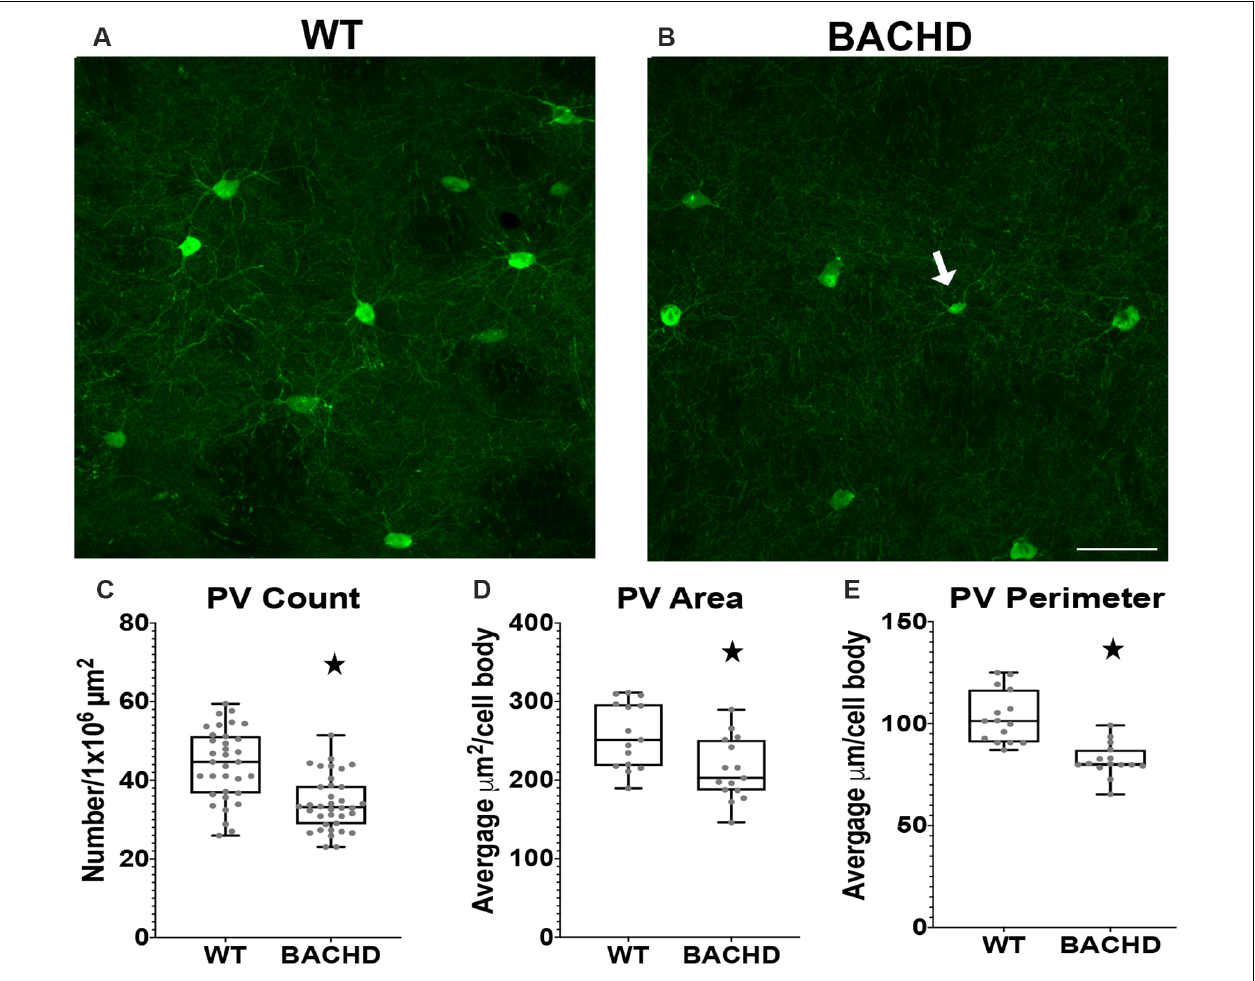
FIGURE 2 | Parvalbumin interneuron numbers and sizes are decreased in the striatum of BACHD mice. Indirect immunofluorescence using an antibody to parvalbumin in the striatum of 12–14 months old WT (A) and BACHD (B) mice. The number (* p < 0.0001; C ), area (* p = 0.0075; D ), and perimeter (* p < 0.0001; E ) of the PV+ neurons are shown. The Mann–Whitney test was used for the analyses. n = 5 WT and n = 5 BACHD. Scale bar is 50 µ m. White arrow indicates a PV+ cell with decreased cell body area and